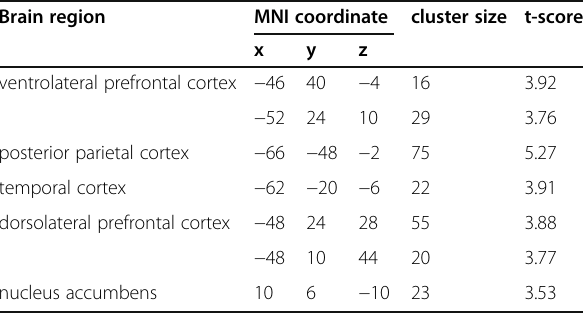
Table 2 Montreal Neurological Institute (MNI) coordinates, cluster size and t-score for regions with greater signal intensity changes Brain region MNI coordinate cluster size